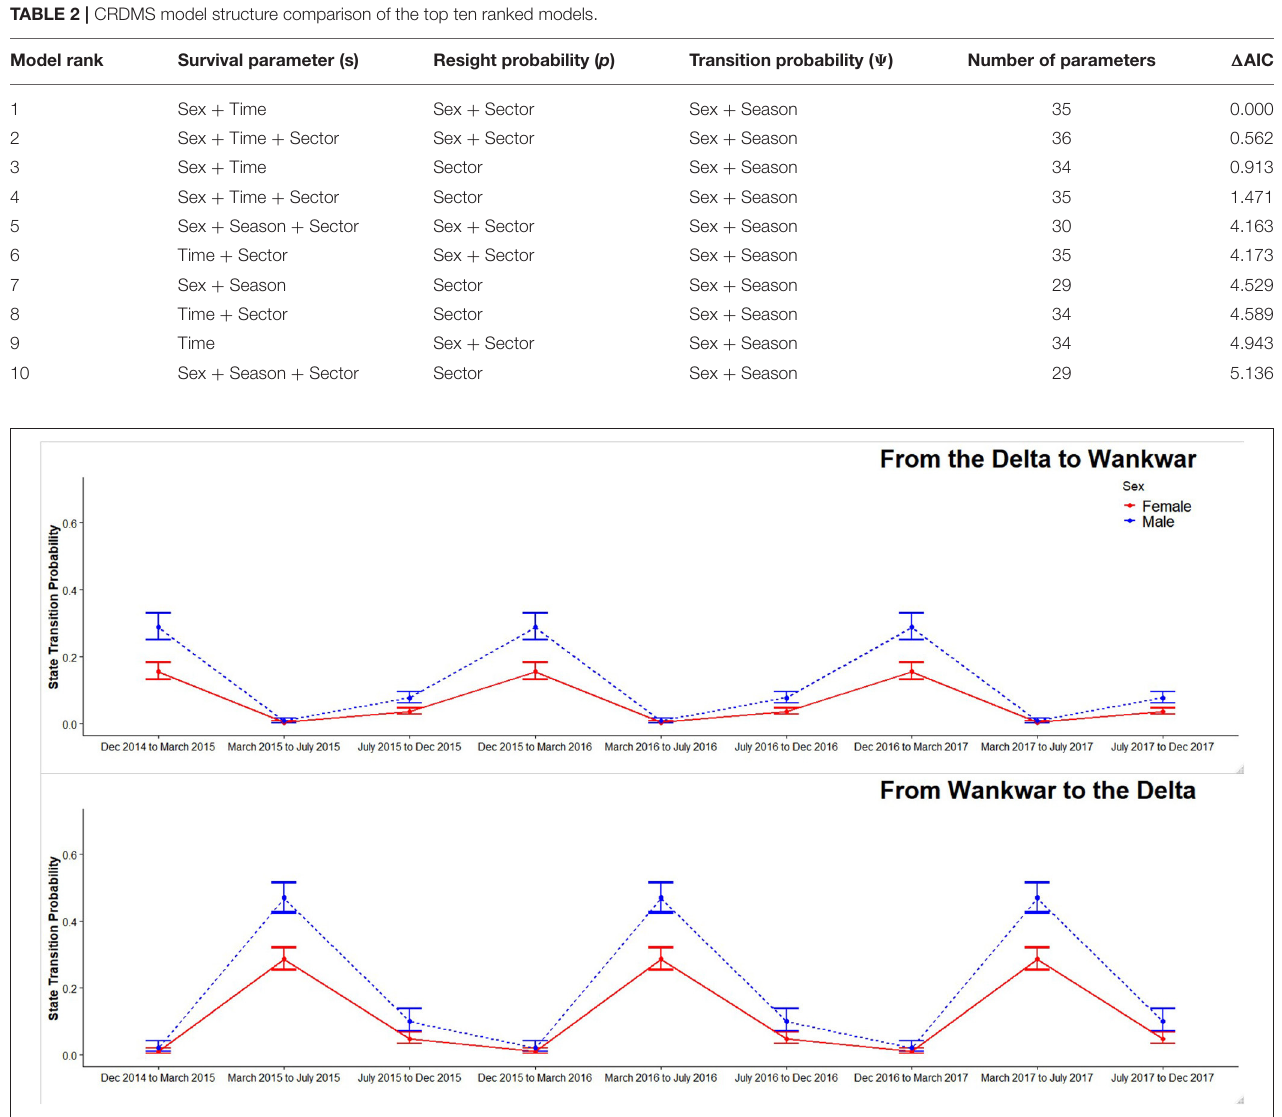
FIGURE 5 | Seasonal estimates of transition probabilities between Wankwar and the Delta for both male and female giraffe. Season and sex varying transition probabilities are drawn from the best supported multi-state mark recapture model with error bars representing 95% CI.